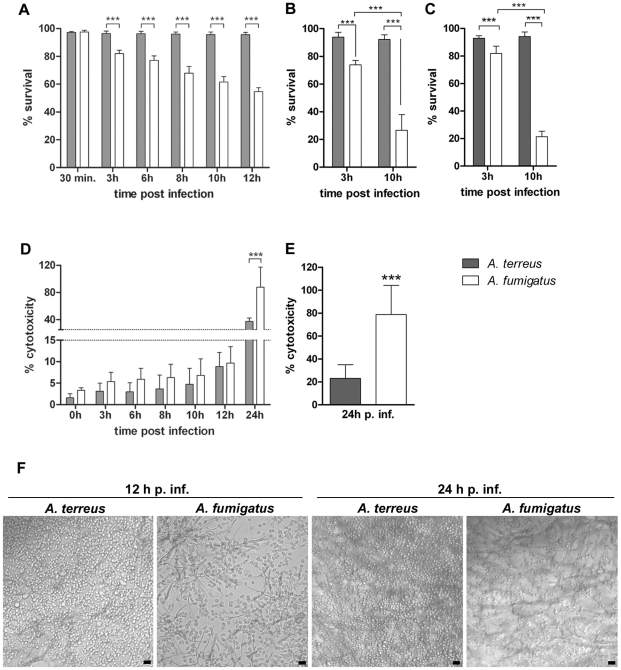

A. fumigatus and A. terreus survival, host cell damage and hyphal growth in co-incubation with macrophages.
Results are shown for A. terreus SBUG844 and A. fumigatus CBS144.89. (A–C) Survival of A. fumigatus and A. terreus upon co-incubation with macrophages. Data is shown as mean+SD from three independent experiments; statistical analysis by 1-way ANOVA and Tukey's multiple comparison test. * P<0.05; ** P<0.01; *** P<0.001. (A, B) Co-incubation with MH-S cells and (C) with bone marrow-derived murine macrophages (A) Survival of A. terreus and A. fumigatus determined by fluorescence microscopy using the metabolic dye FUN1. (B, C) Survival determined by CFU. (D, E) Relative cytotoxicity of A. terreus and A. fumigatus conidia to (D) MH-S cells and (E) human monocyte-derived macrophages determined by release of lactate dehydrogenase (LDH). Mean values+SD from three independent experiments; statistical analysis was performed per time point by unpaired, two-tailed t-test. * P<0.05; ** P<0.01; *** P<0.001 (F) Microscopic picture showing germination and filamentous growth of A. fumigatus and A. terreus 12 h (left) and 24 h (right) after infection. Scale bars = 40 µm.